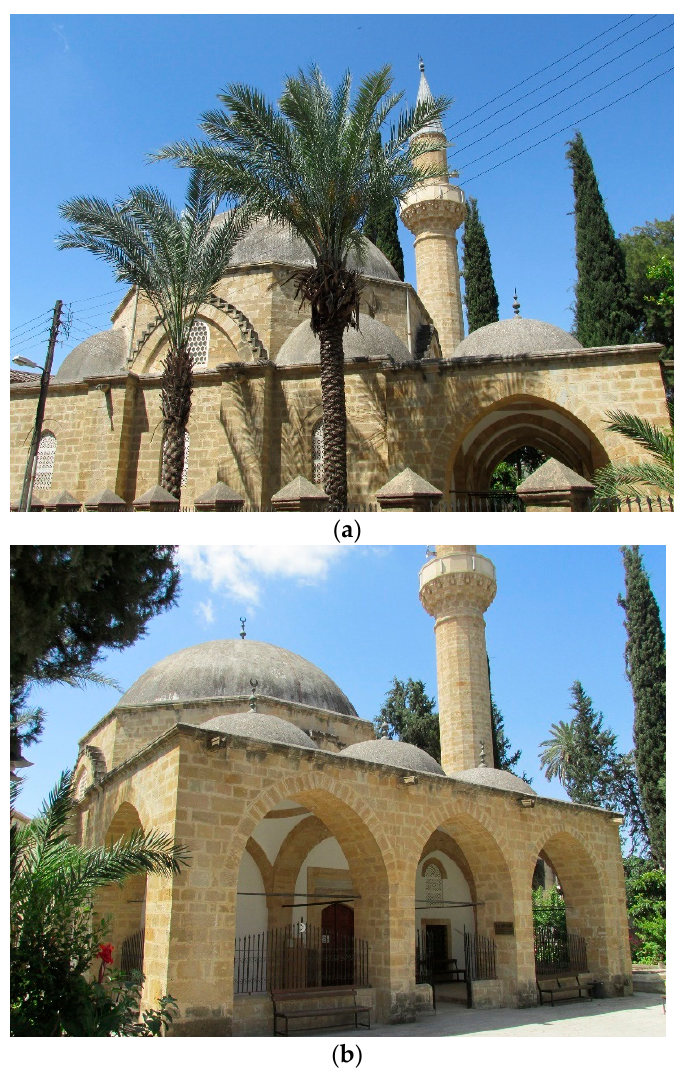
Figure 2. Nicosia, Arab Ahmet Pa ş a mosque, 16th/17th centuries and 1845 (Ottoman type): ( a ) lateral facade of the prayer hall and frontal portico; ( b ) front facade with arcaded portico (photos: